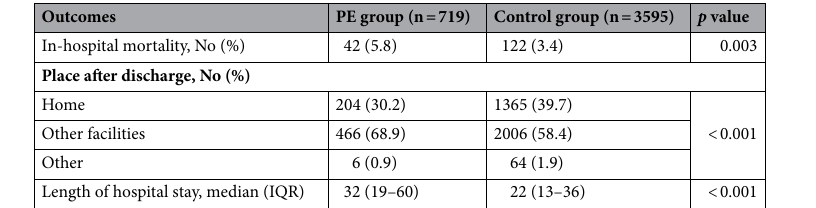
Table 2. Outcomes of patients with and without pulmonary embolism. Missing data: In-hospital mortality = 32; Place after discharge = 203. PE pulmonary embolism, IQR interquartile